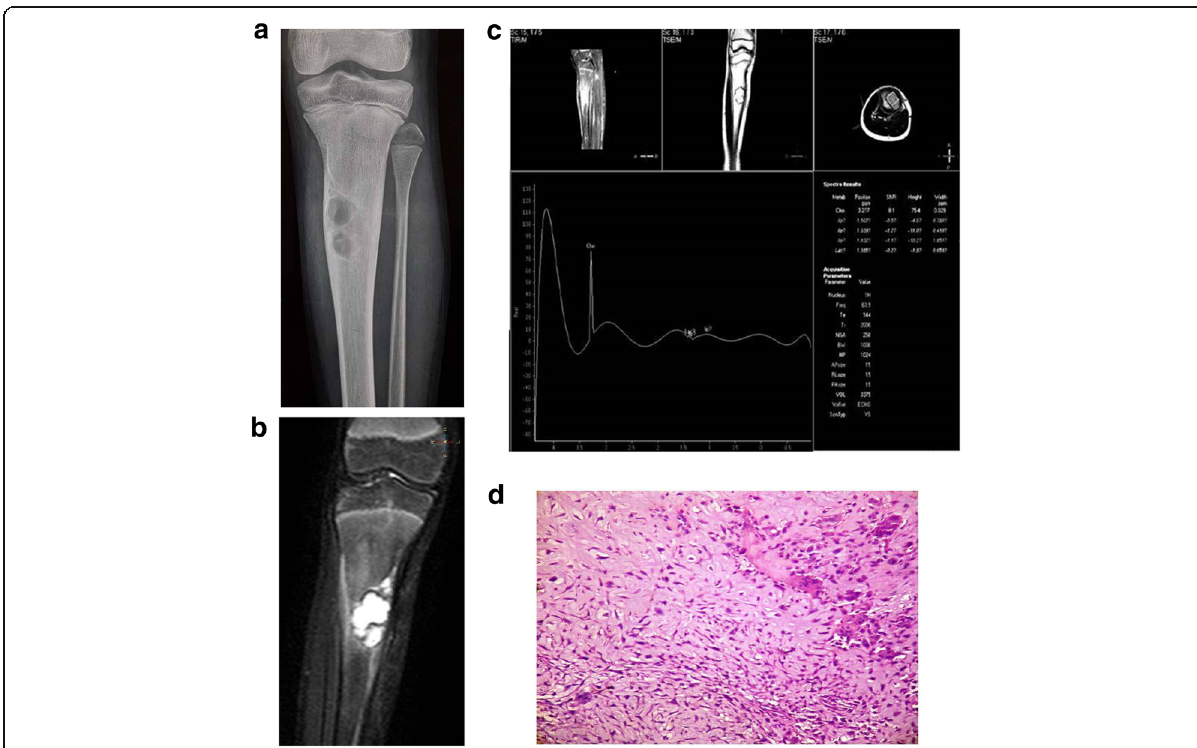
Fig. 8 A 13-year-old male patient with pain in the right leg. a . AP radiograph of the left leg. A geographical metaphyseal lytic lesion (arrow) having a thin sclerotic rim suggestive of a benign lesion. b STIR coronal image shows a well defined hyperintense eccentric metaphyseal lesion in right tibia. c MRS shows choline peak at 3.2 ppm. d HNE 200× shows lobule of myxoid material with stellate cells displaying hypercellularity at the periphery along with giant cells diagnostic of chondromyxoid fibroma